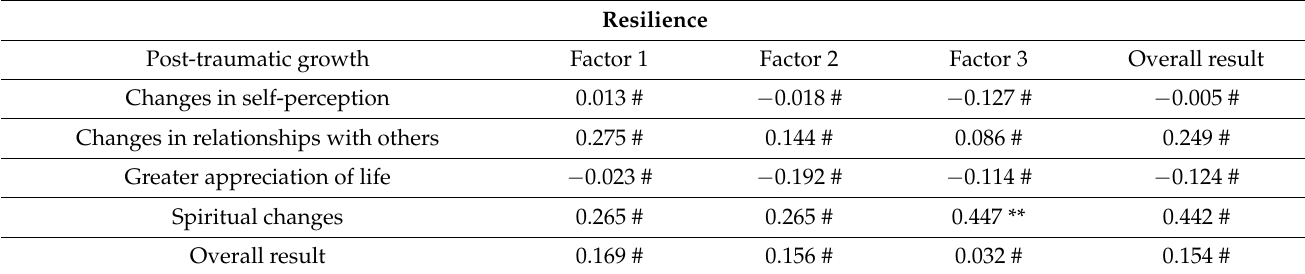
Table 4. The values of the correlation coefficient of alexithymia with post-traumatic growth in a recipient from a living donor. Resilience